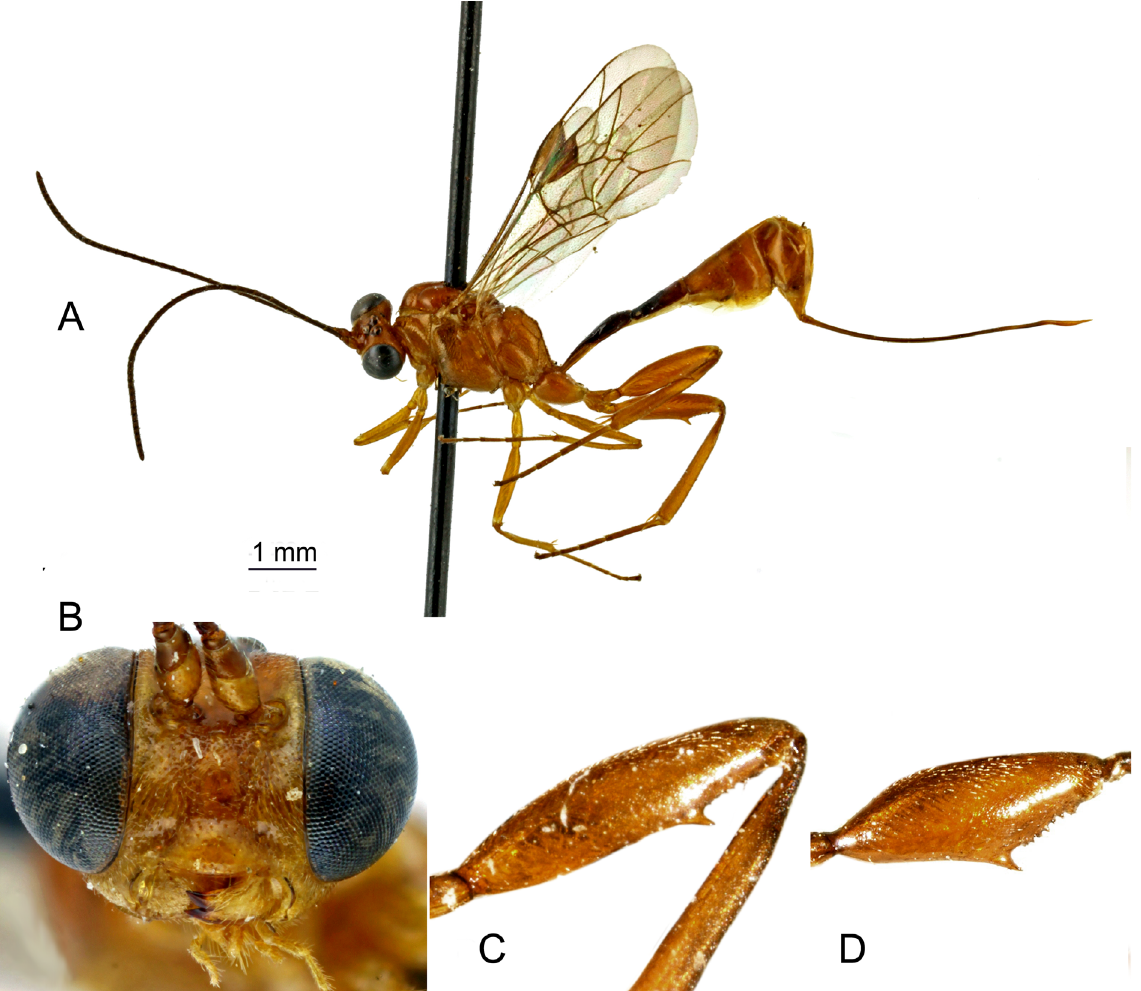
Fig. 17. Pristomerus yago sp. nov. A . ♀, habitus, profile. B . ♀, head, facial. C . ♀, hind femur, profile. D . ♂, hind femur,